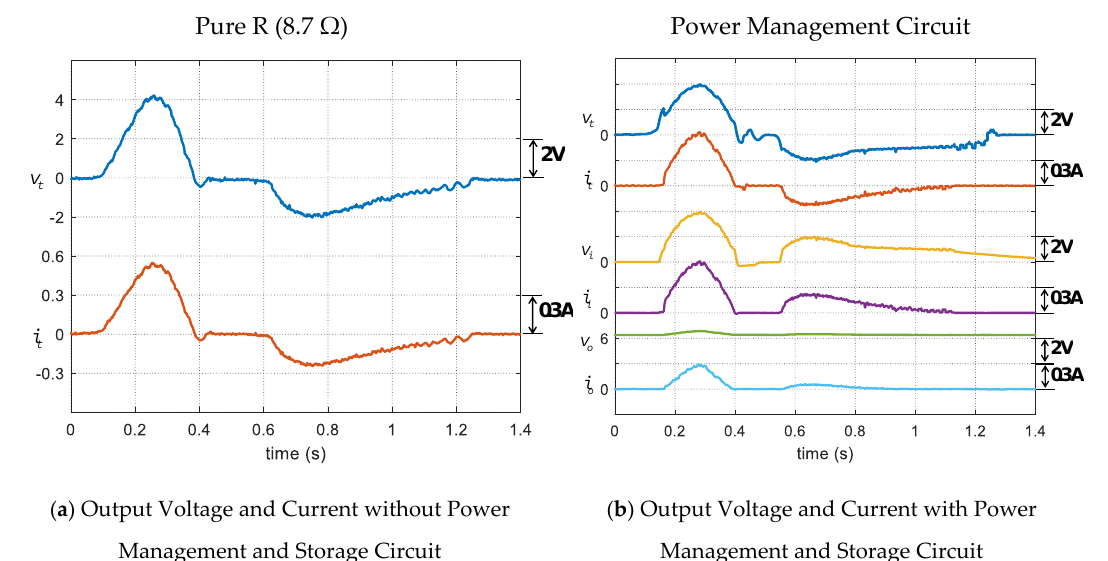
Figure 19. Experimental result showing the operation of power management and storage circuit; 𝑣 𝑡 and 𝑖 𝑡 are outputs of generator; 𝑣 𝑖 and 𝑖 𝑖 are outputs of the rectifier circuit; 𝑣 𝑜 and 𝑖 𝑜 are outputs of the buck-boost circuit.